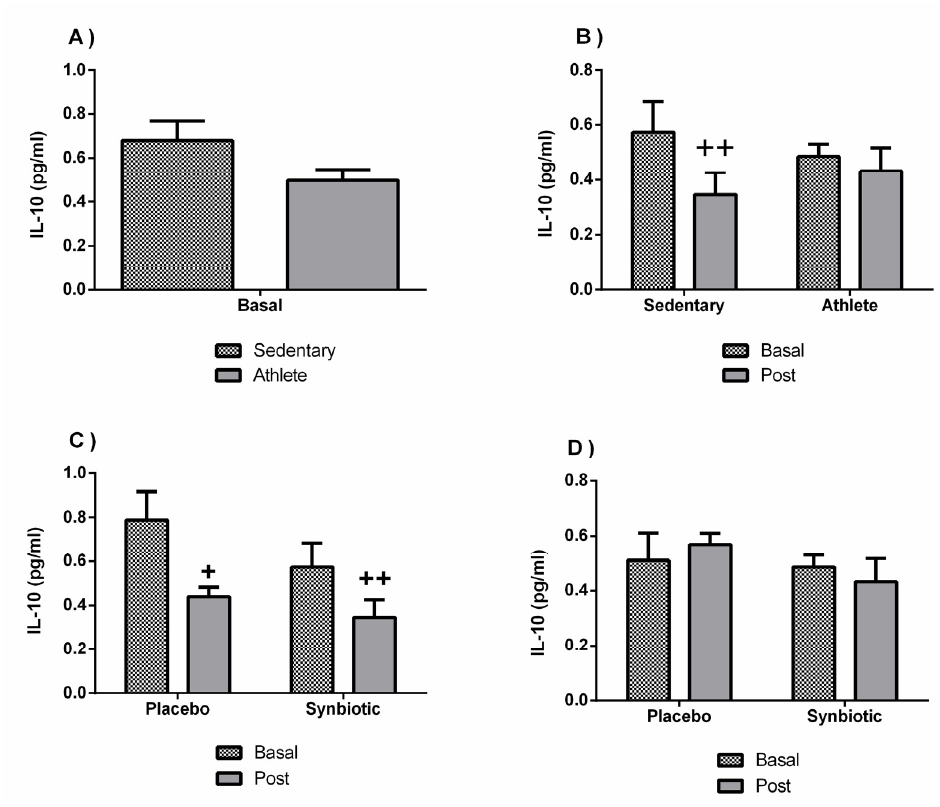
Figure 6. Effect of training and consumption of a synbiotic in this condition on cytokine IL-10. ( A ) Basal serum IL-10 concentrations in sedentary men ( n = 14) and athletes ( n = 13); ( B ) Influence of training on the effects of the synbiotic on serum IL-10 concentration ( n = 7 and n = 6 in sedentary and athlete groups, respectively); ( C ) Effect of the consumption of the synbiotic on IL-10 in sedentary individuals with respect to placebo ( n = 7) or with synbiotic ( n = 7); ( D ) Effect of the consumption of the synbiotic on IL-10 in athlete individuals with placebo ( n = 6) or with synbiotic ( n = 7). The determinations are expressed by the mean ± SD of each of the samples. + p < 0.05 and ++ p < 0.01 with respect to the baseline.